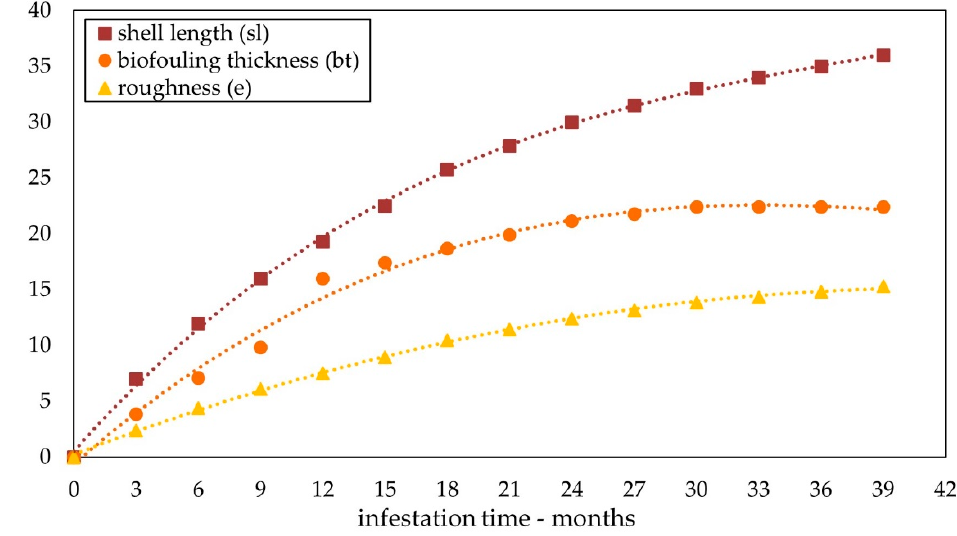
Figure 5. Golden mussel growth curve based on shell length (sl), average thickness of biofouling (bt), and surface roughness (e). All data are related to time and were obtained from Table 3.